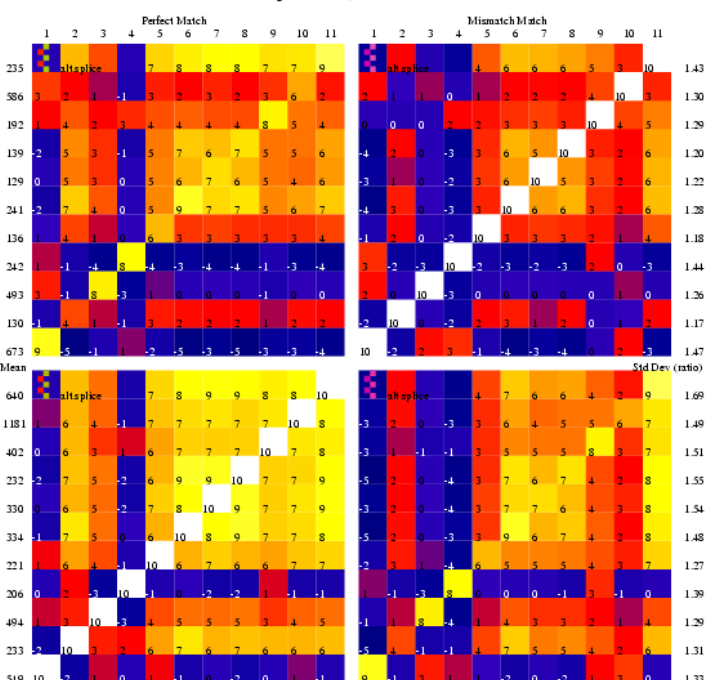
Figure 7: The correlations in intensities (log2) between probes in probeset 208772 at on the HG- U133A array. The numbers to the left indicate the mean linear intensity of each probe across all the data in GEO. The numbers to the right indicate the standard deviation of the normalised log2 intensities for all the data in GEO. The lower left quadrant details the correlations between perfect match probes and all the other perfect match probes in the probeset. The upper right quadrant details the correlations between all the mismatch probes. The upper left quadrant details the correlations between the perfect match and mismatch probes. The number in each square is the correlation × 10. The matrix is diagonally symmetric, and the diagonal corresponds to comparing a probe with itself – perfect correlation, and hence is scored 10. The correlation calculated for PM probes 9 and 11 , the data in Figure 3, is reported as 8 (0.76 multiplied by 10 and